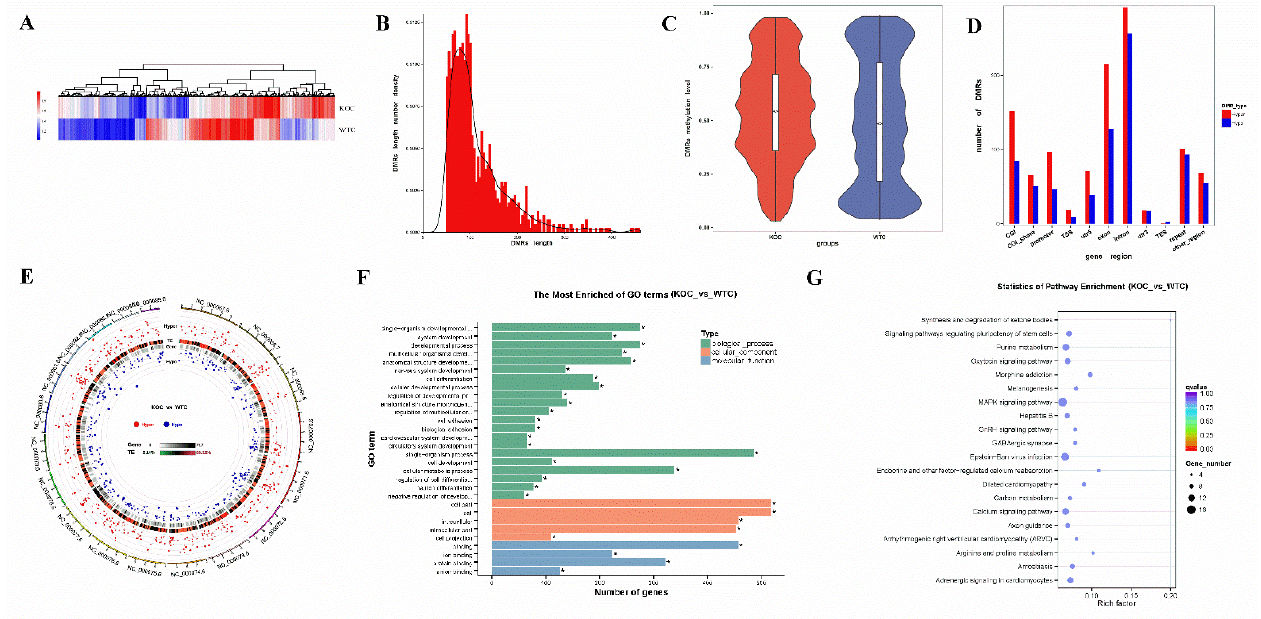
Figure 5. The characters of DMRs. ( A ) DMR cluster analysis using heat map. ( B ) Distribution of DMR lengths. ( C ) The methylation level of DMRs in KO and WT groups. ( D ) The number of DMR distributed in CGI, CGI shore, promoter, TSS, 5′ UTRs, exons, introns, 3′U TRs, TES, repeats and other regions. ( E ) Circos plots of the distribution and statistical significance of DMRs in each chromosome. The red and blue dots indicated hypermethylated and hypomethylated DMRs, and one larger in size and outer in position indicated a more significant difference. ( F ) Most enriched GO terms. ( G ) The results of KEGG pathway enrichment.